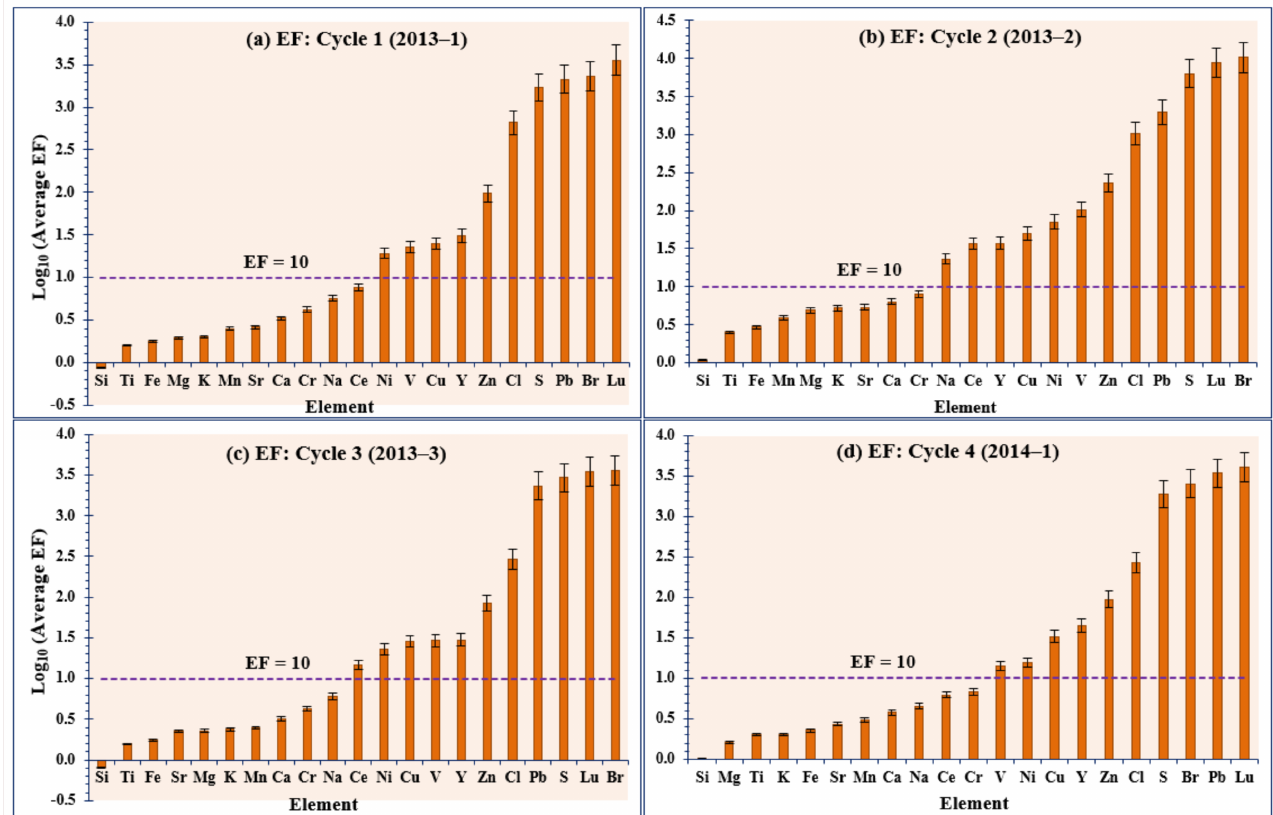
Figure 5. The log transformed enrichment factors (EFs) of trace elements measured from PM 2.5 per cycle—averaged sampling sites: cycle 1—( a ), cycle 2—( b ), cycle 3—( c ), cycle 4—( d ). Elements with EF values exceeding 10 (as indicated by the dotted line), have significant proportions coming from anthropogenic emission